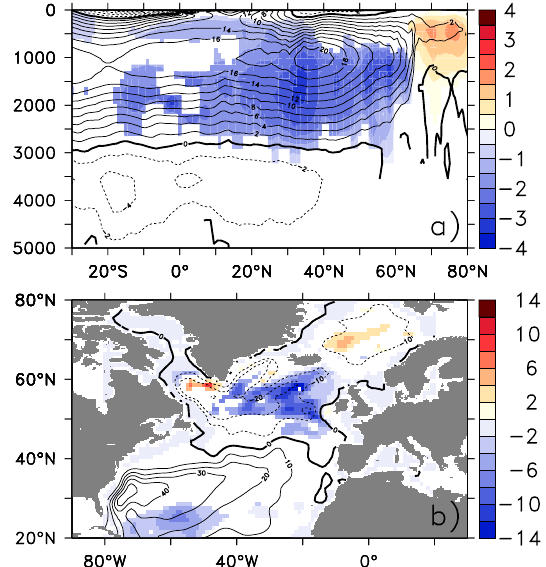
Figure 4. Simulated 20th-century linear trends (1905–2005) in the pr2 simulation (colour shading) of (a) meridional overturn- ing circulation and (b) barotropic stream function in the North Atlantic. Units are sverdrups (1Sv = 10 6 m 3 s − 1 ) per 100 years. Contour lines (contour intervals 2Sv for overturning and 10Sv for barotropic stream function) describe the pre-industrial mean state. In both panels, only anomalies are shown that exceed the 5th–95th- percentile range of centennial trends derived from the PiCtrl simu- lations.